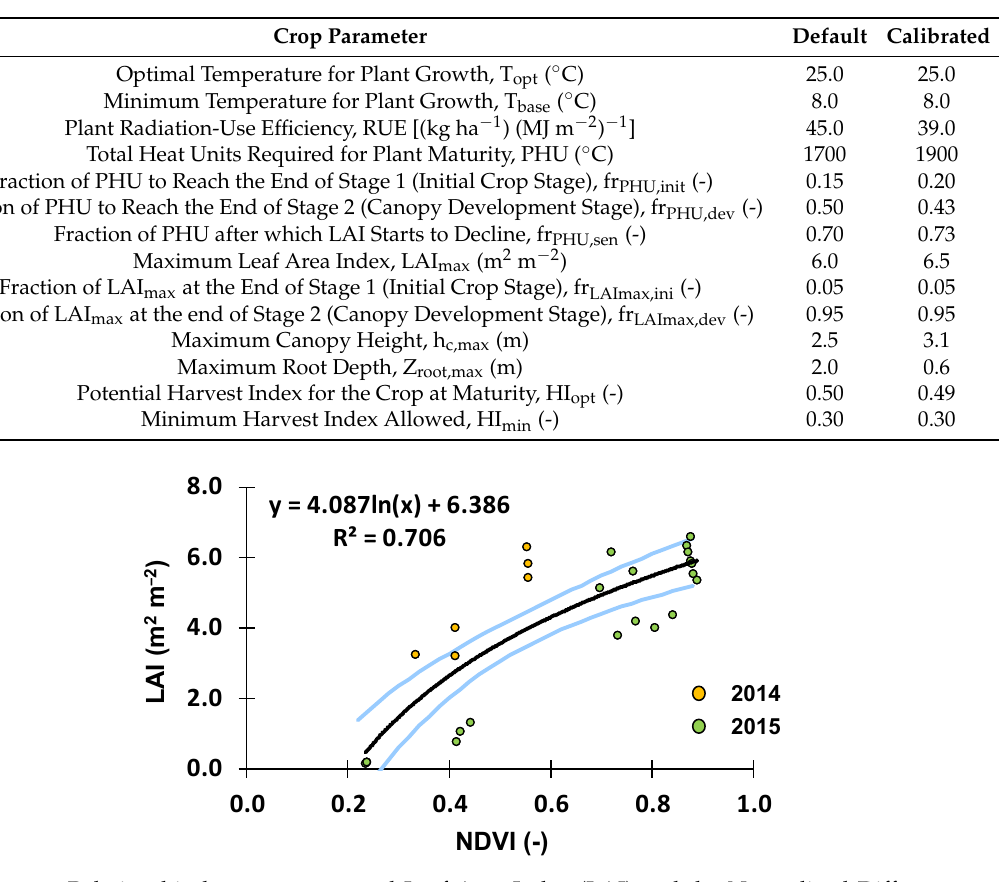
Figure 3. Relationship between measured Leaf Area Index (LAI) and the Normalized Difference Vegetation Index (NDVI). The blue lines correspond to the 95% confidence interval.